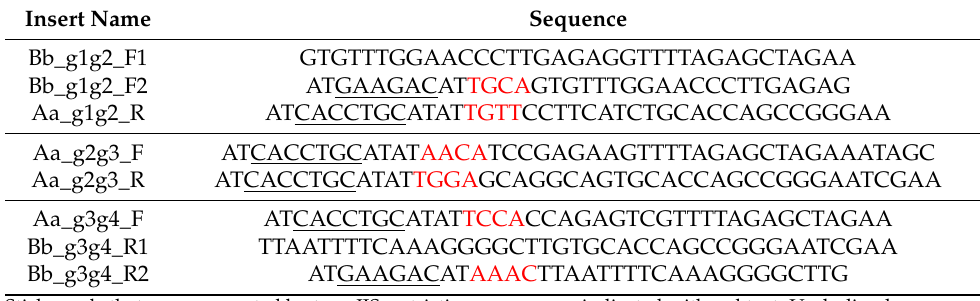
Table 16. List of primers for pBAtC_4sg insert fragments.